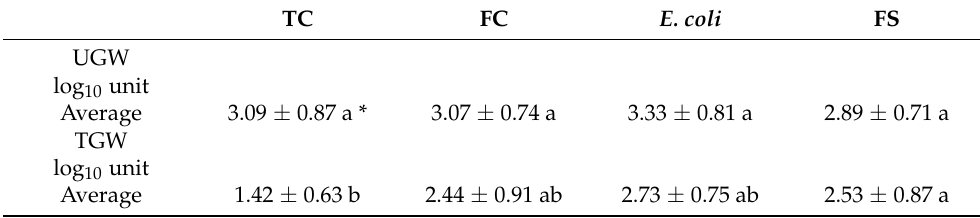
Table 2. Average bacteria removal efficiency in vertical greywater treatment system. TC FC E.